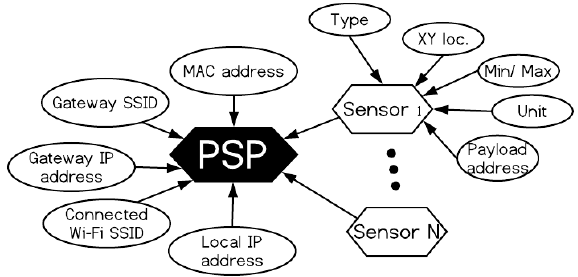
Figure 3. An example of a physical system profile (PSP) configuration showing the type of information it holds.